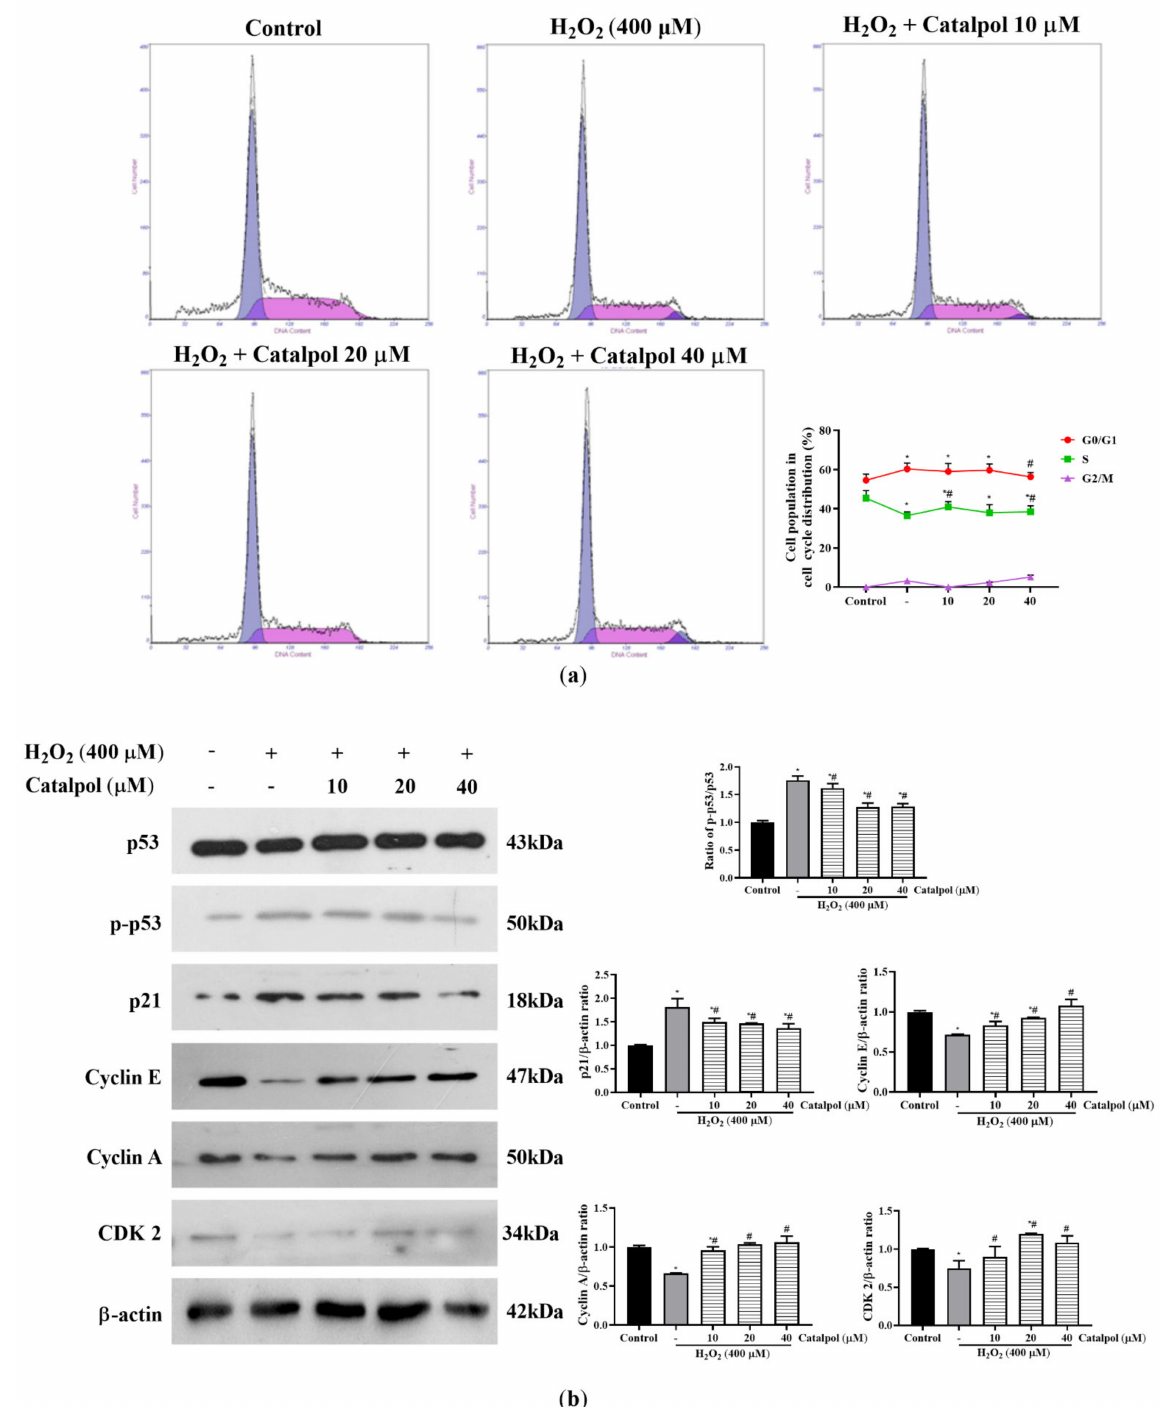
Figure 3. Effect of catalpol on cell cycle arrest in H 2 O 2 -induced RPE cells. ( a ) ARPE-19 cells were pretreated with or without catalpol (10, 20, and 40 µ M) for 24 h and then treated with 400 µ M H 2 O 2 for 6 h. The cell cycle progression was